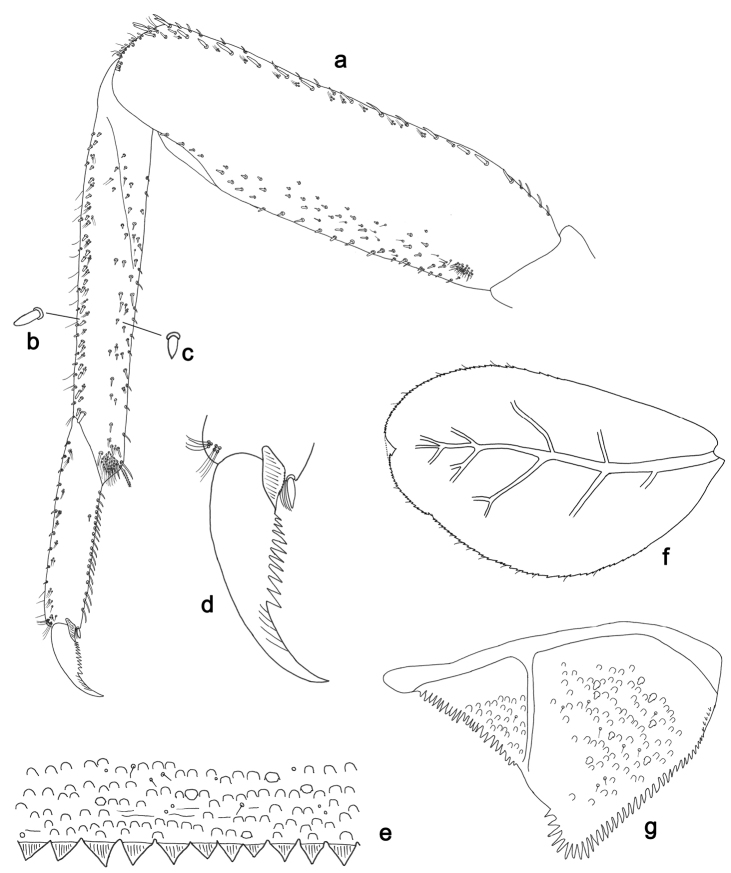
Labiobaetiscentralensis sp. n., larva morphology: aForelegb Tibia dorsal seta c Tibia ventral seta d Fore claw eTergum IV f Gill IV gParaproct.